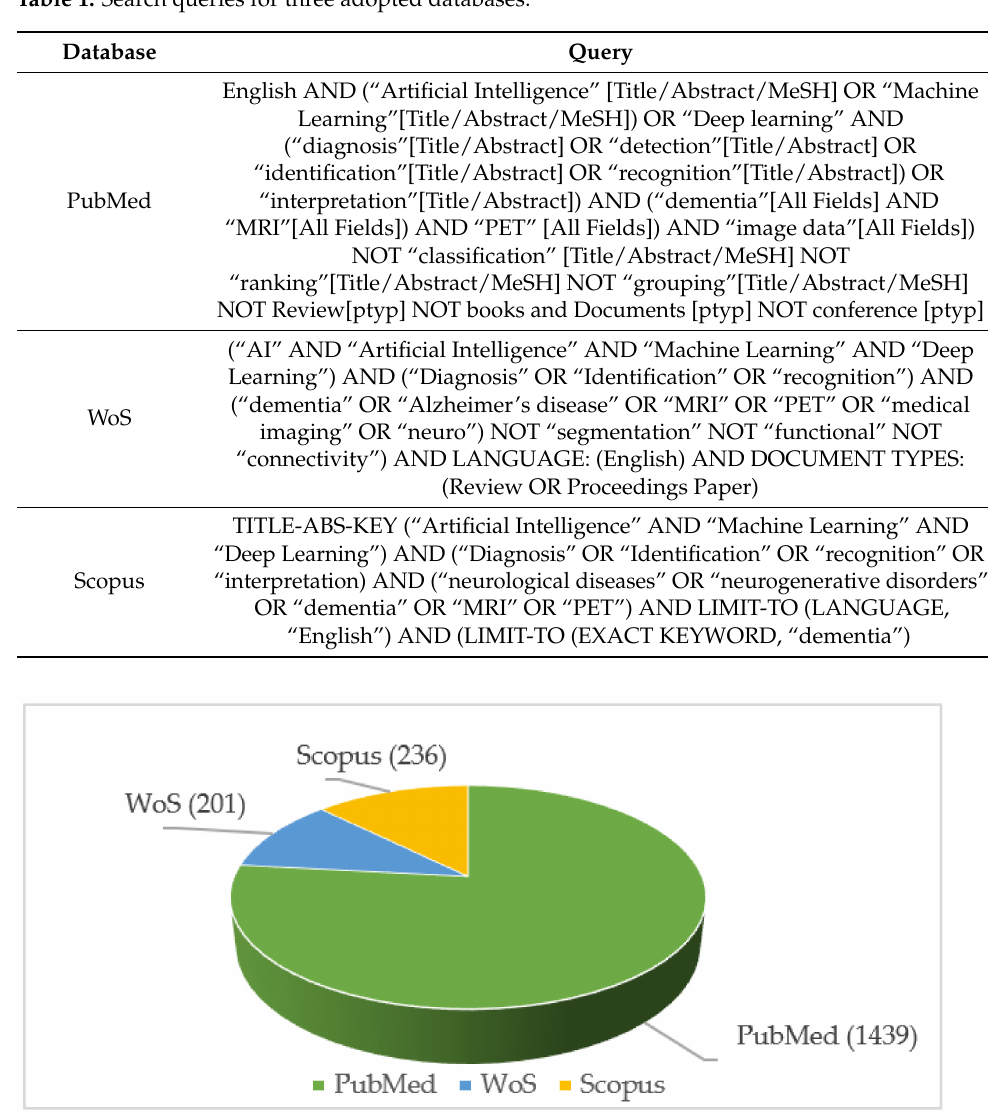
Table 1. Search queries for three adopted databases.